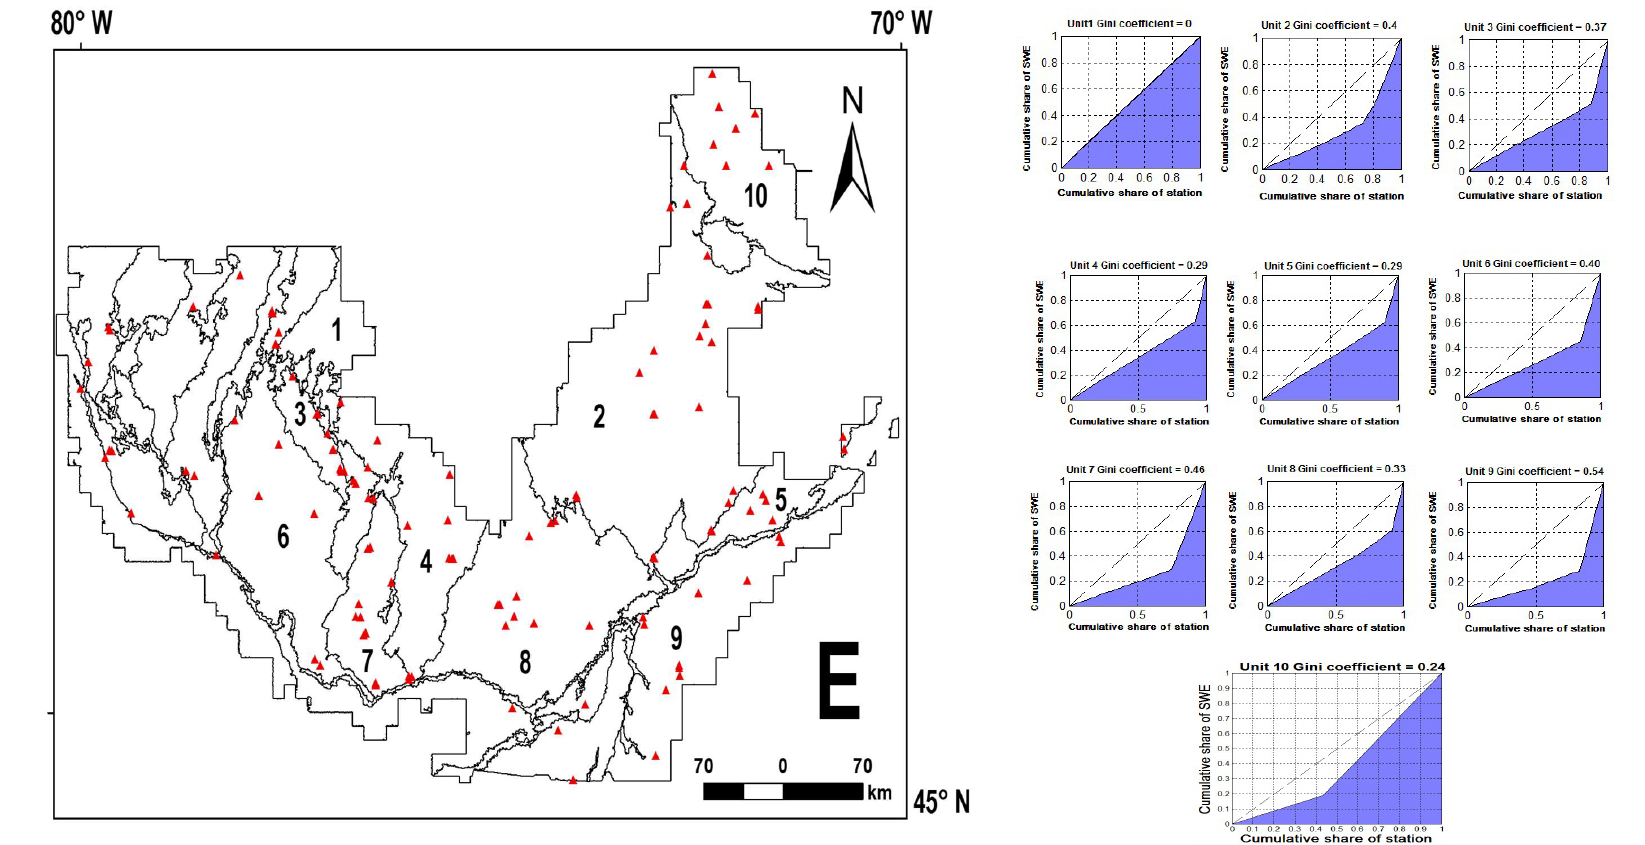
Figure 9. Lorenz curves and values of spatial distribution unevenness of stations in the units of zone E, at the local scale.